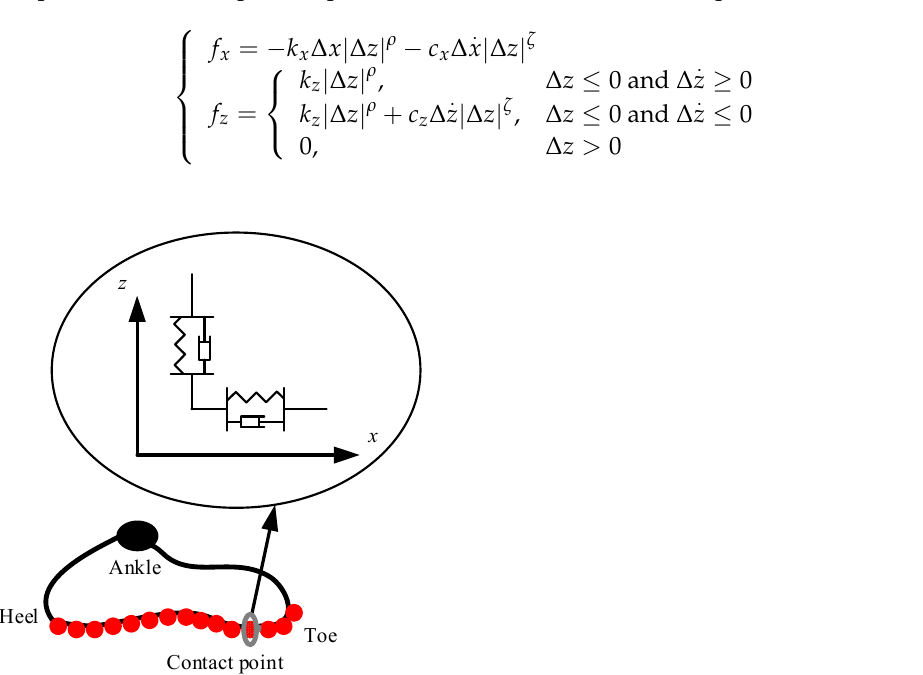
Figure 15. Contact model of the foot and ground. Table 3. PID parameters for each joint.